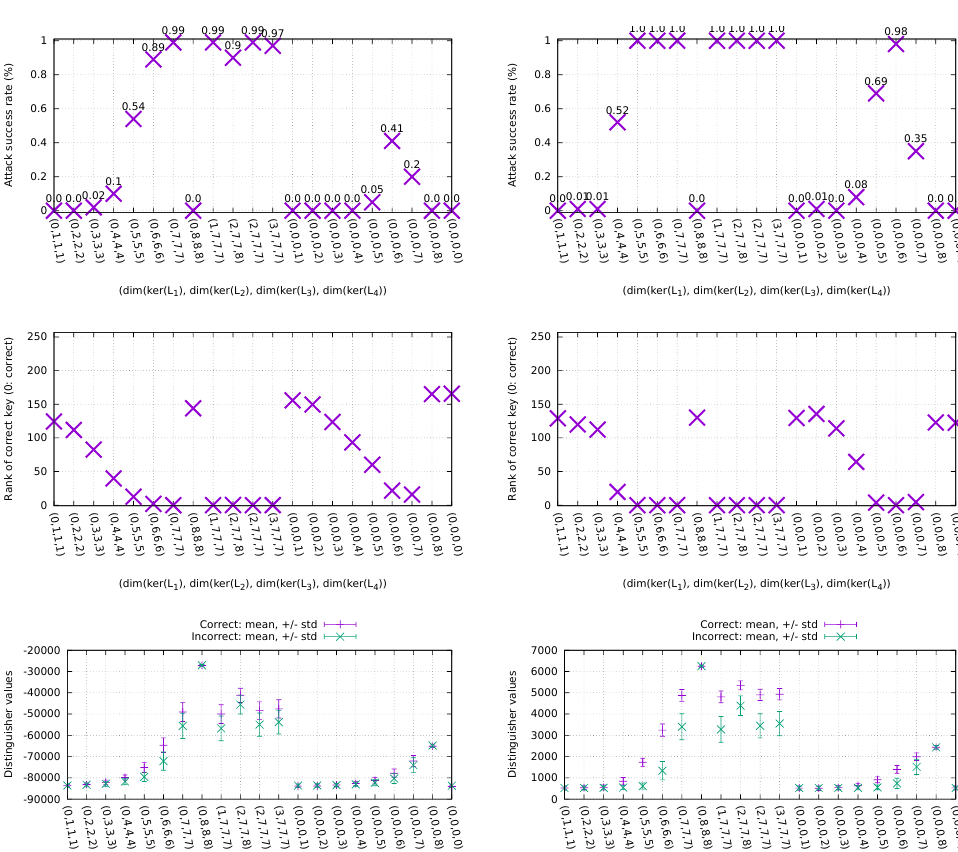
Figure 3: Distinguisher performance comparison between [SMG16] and